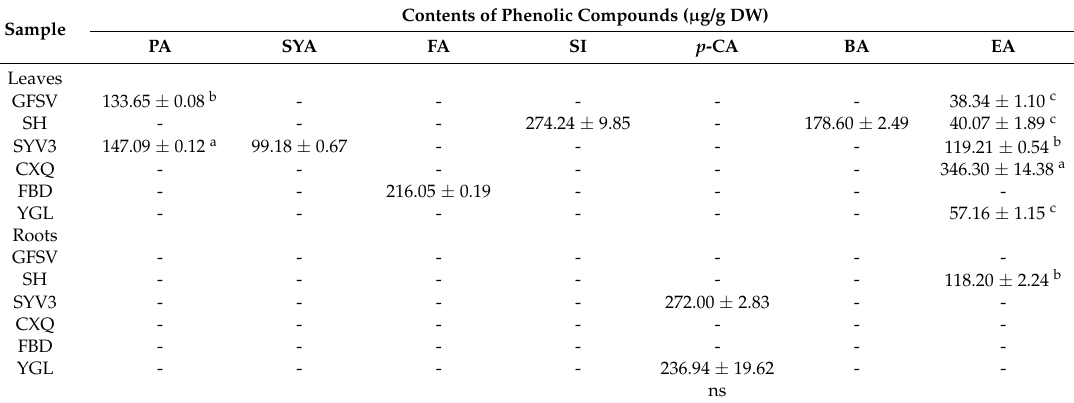
Table 3. Phenolic compounds of free form extracts of Phal. hybrids.